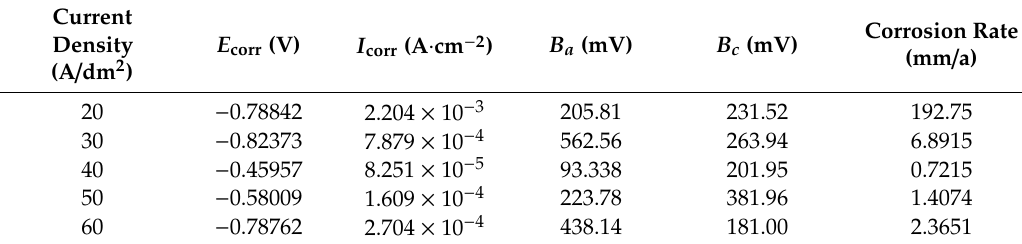
Table 5. Parameter values of polarization